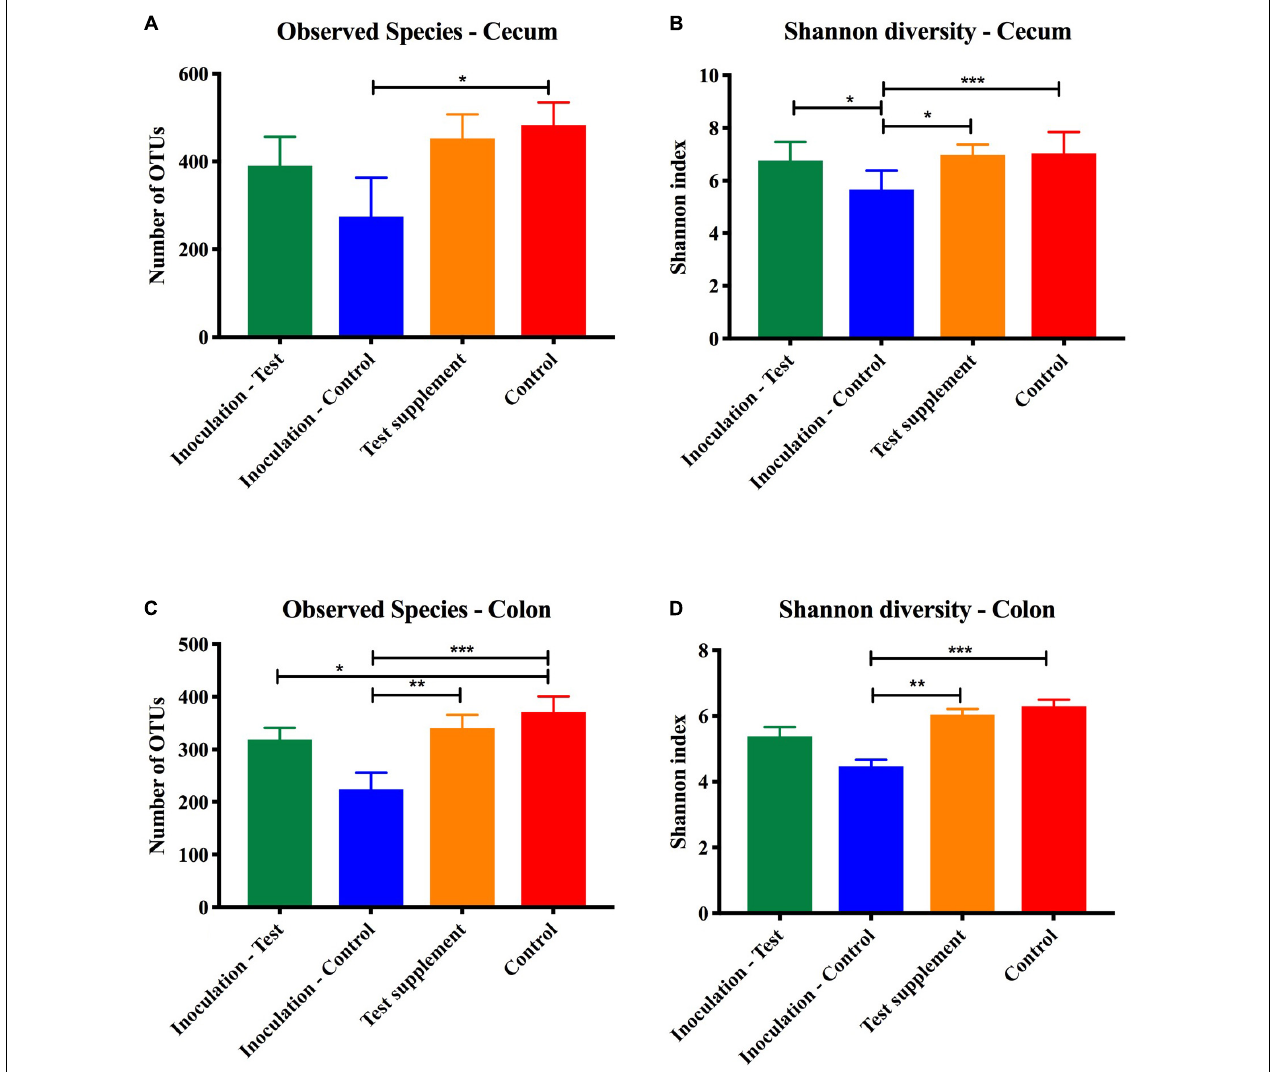
FIGURE 6 | Alpha diversity measured on 16S rRNA extracted from cecal and colon content at termination of mice inoculated with microbiota from foals fed either a test supplement enriched with oligosaccharides (green) or a control diet (blue) or fed a mouse diet with (orange) or without (red) oligosaccharides. Shown qualitatively as number of observed OTUs (mean, SD) and quantitatively by the Shannon index (mean, SD). When compared by one-way ANOVA significant differences were found in the colon content but not in the cecum marked as * p < 0.05, ** p < 0.01, and *** p <